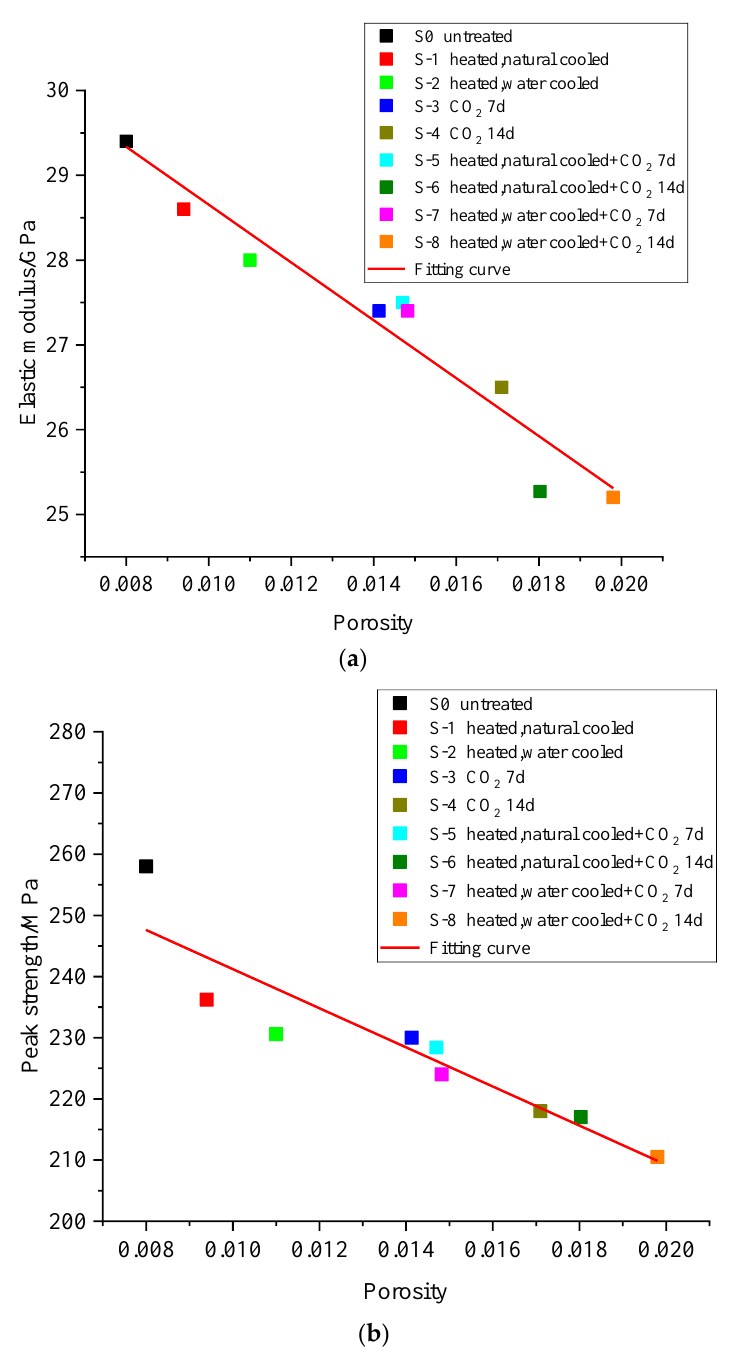
Figure 11. Relationship between mechanical parameters and porosity in granite samples after different types of treatment: ( a ) Elastic modulus; ( b )compressive strength.